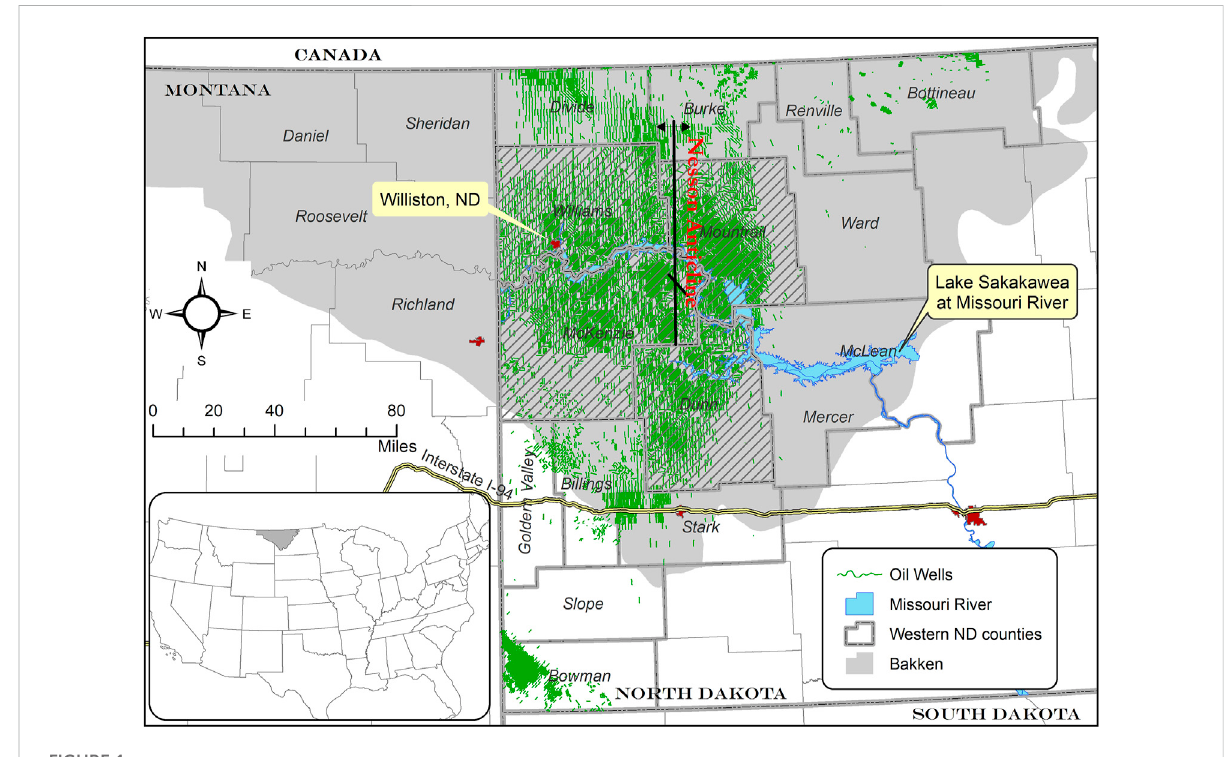
FIGURE 1 Bakken Formation and western North Dakota with horizontal oil